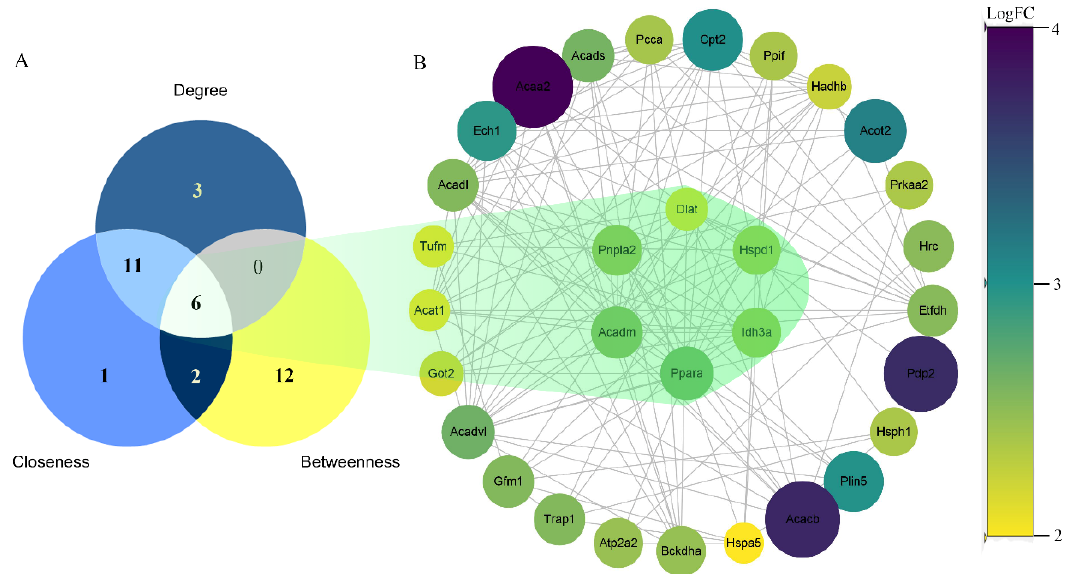
Figure 6. PPI network. ( A ) is Venn analysis with three algorithms. ( B ) is PPI network construction. Each circle represents a gene node. The transition from yellow to purple and the changes in the diameter of the circle indicate an increase in the sum of the absolute values of logFC. The genes with the 6 circles in the center represent the 6 genes with the intersection of the three algorithms.